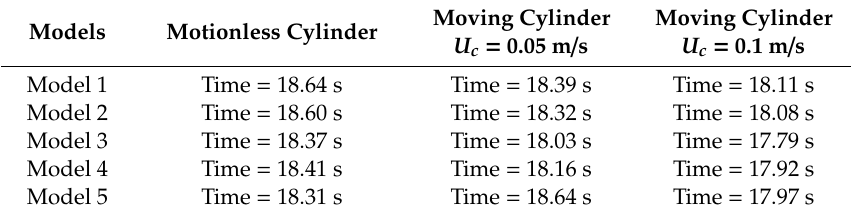
Table 3. The time occurrences of the peaks of the horizontal forces.